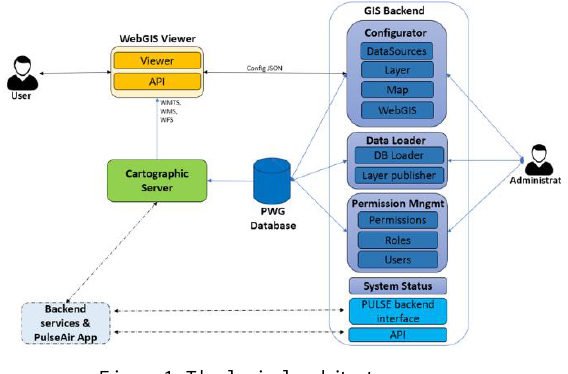
Figure 1. The logical architecture